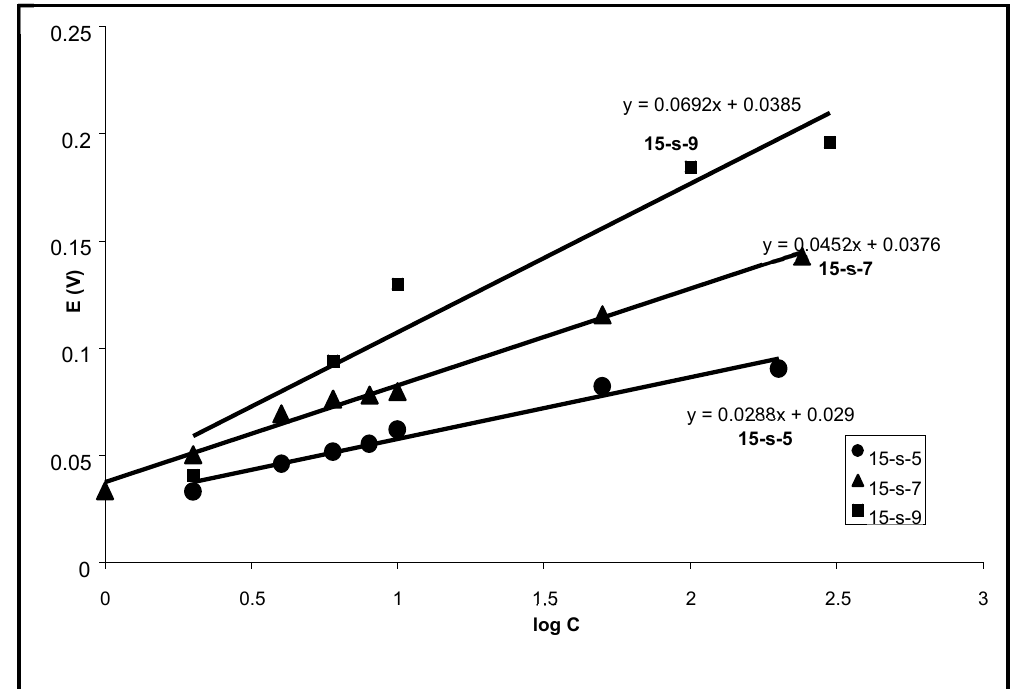
Figure 5. Net changes of the minimum value of the transmembrane potential as a function of log C ( µ m) for different Tergitols: • 15-S-5, (cid:78) 15-S-7 and (cid:4) 15-S-9.